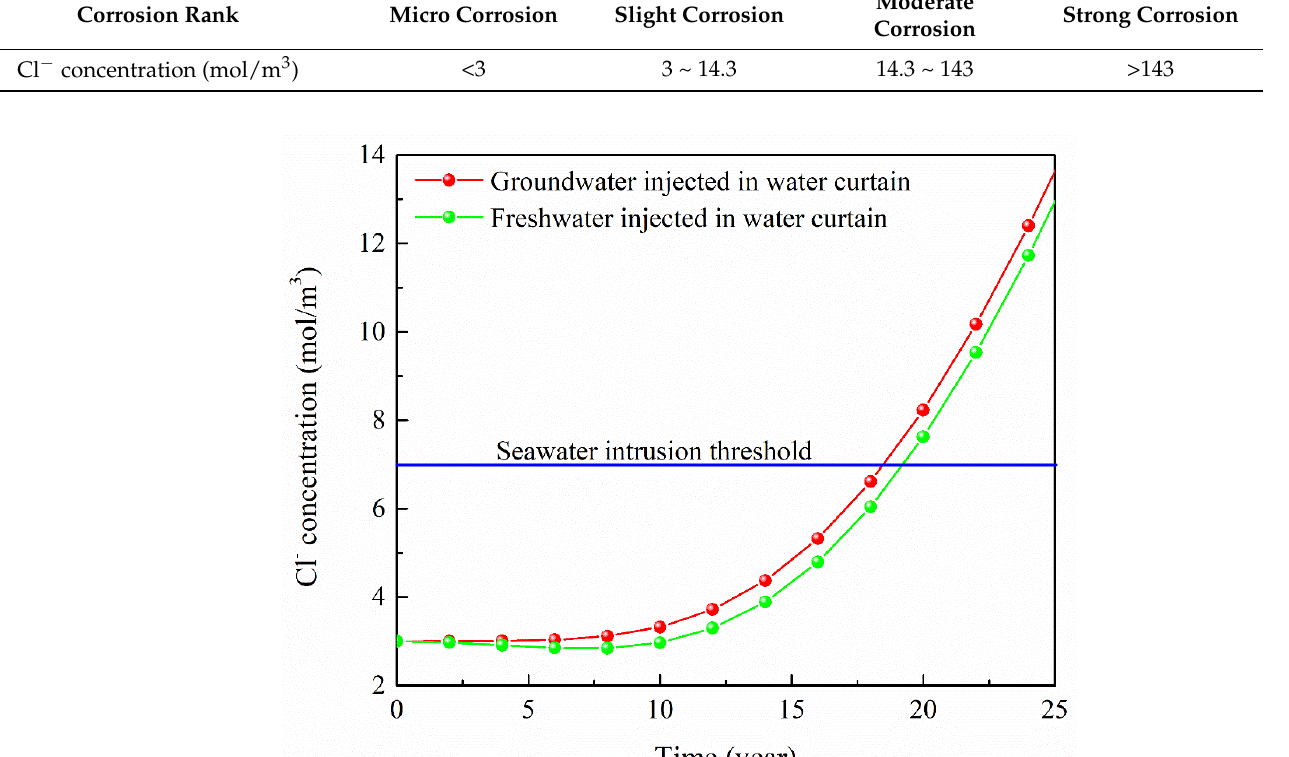
Table 4. Reinforcement steel corrosion rating.